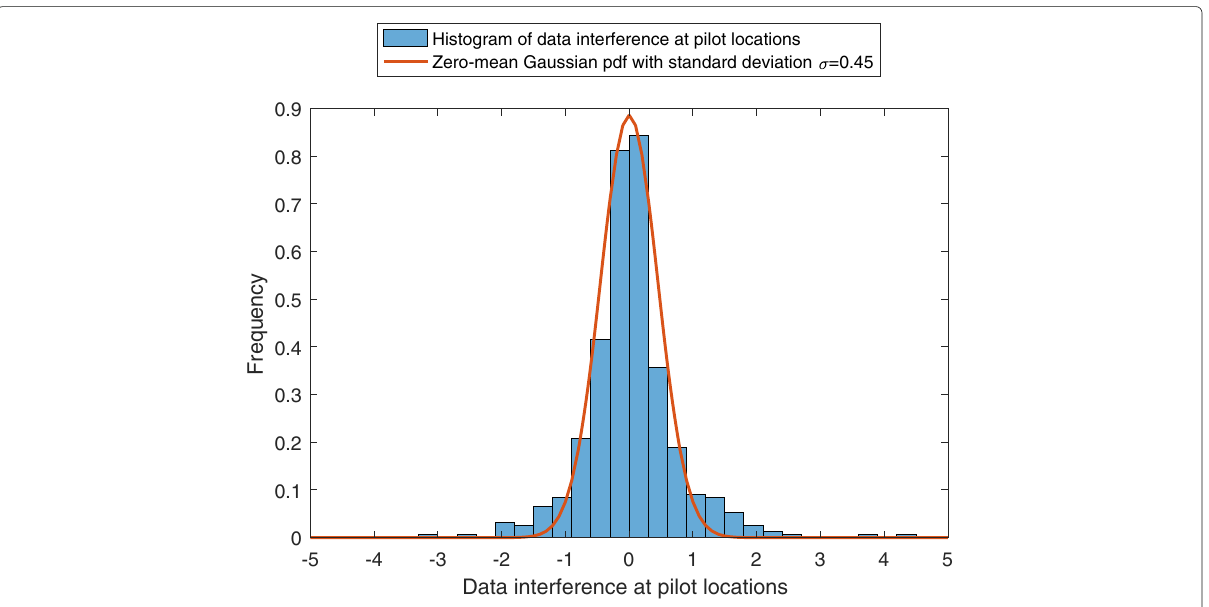
Fig. 8 Histogram of ζ d at pilot locations in presence of fading channel, STO and k , n